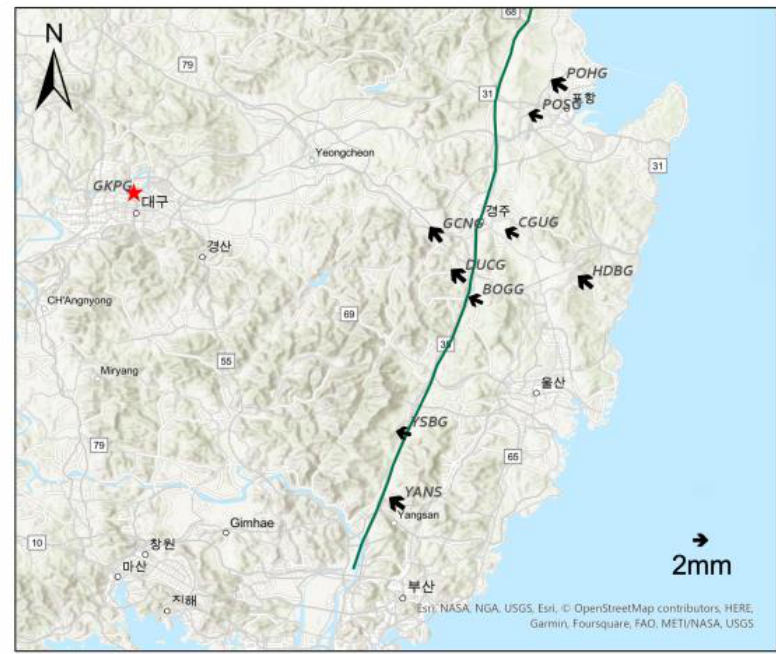
Figure 6. Displacement of station that GKPG fixed.